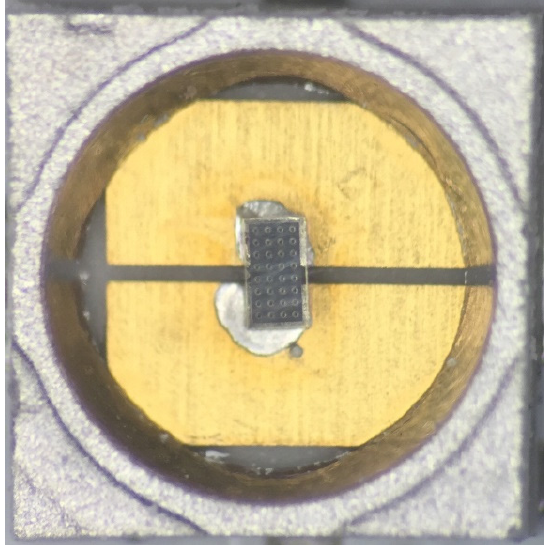
Figure 10. Top views of a packaged aluminum sidewall DUV-LED .